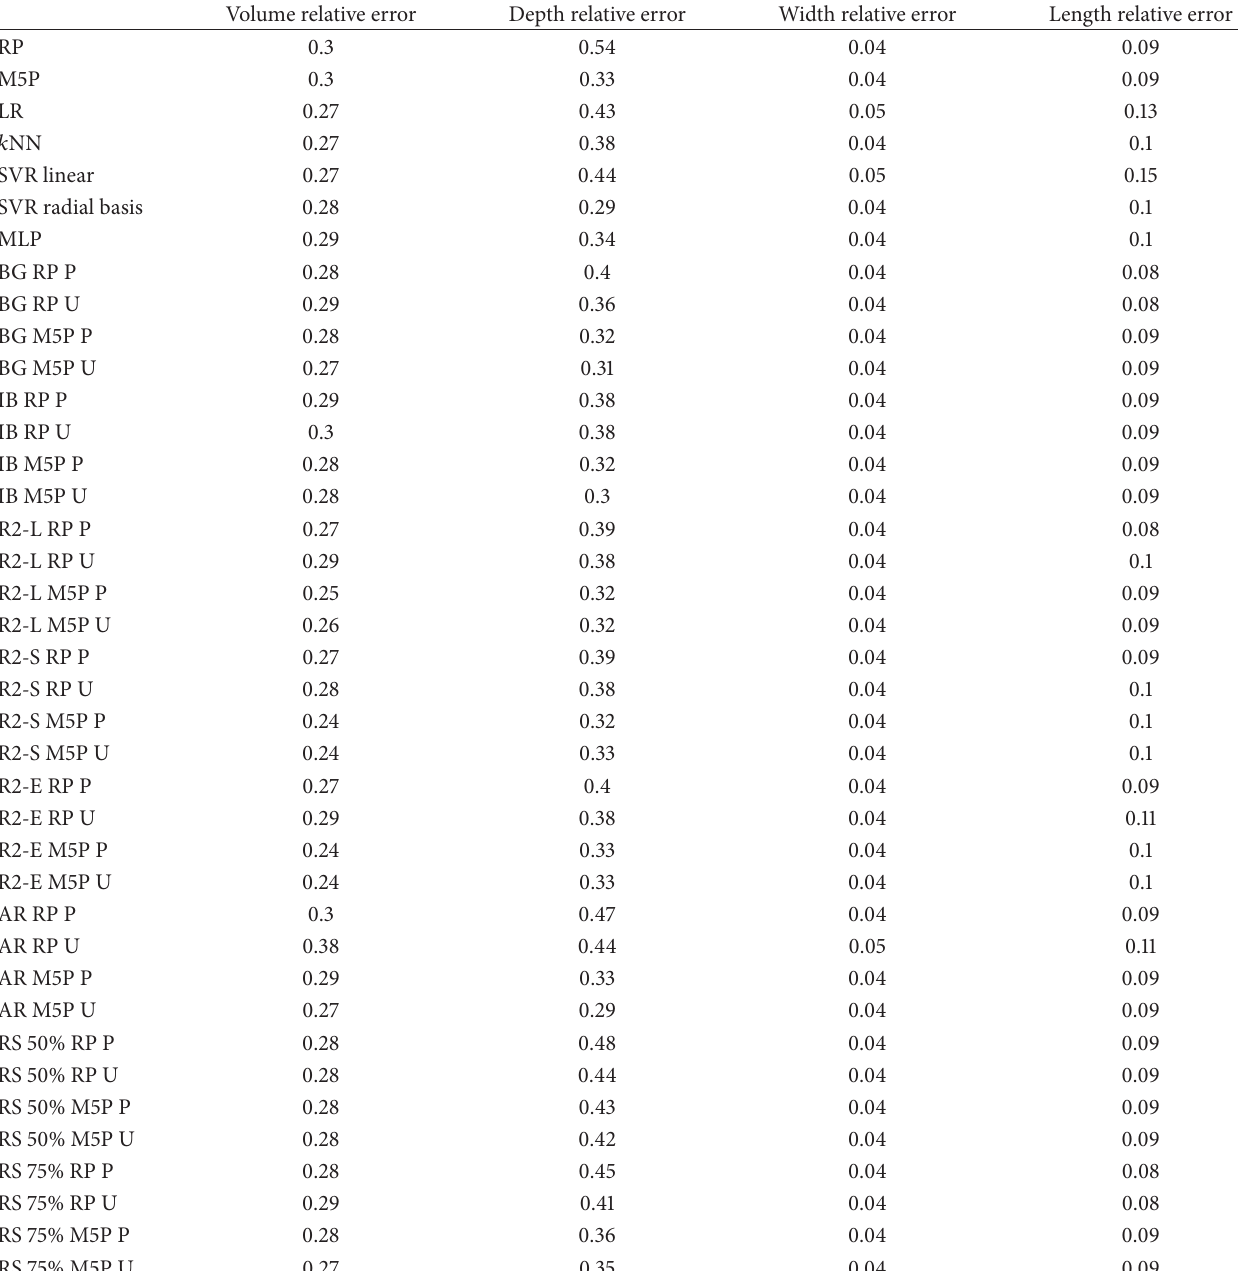
Table 9: Root mean squared error 3/3.